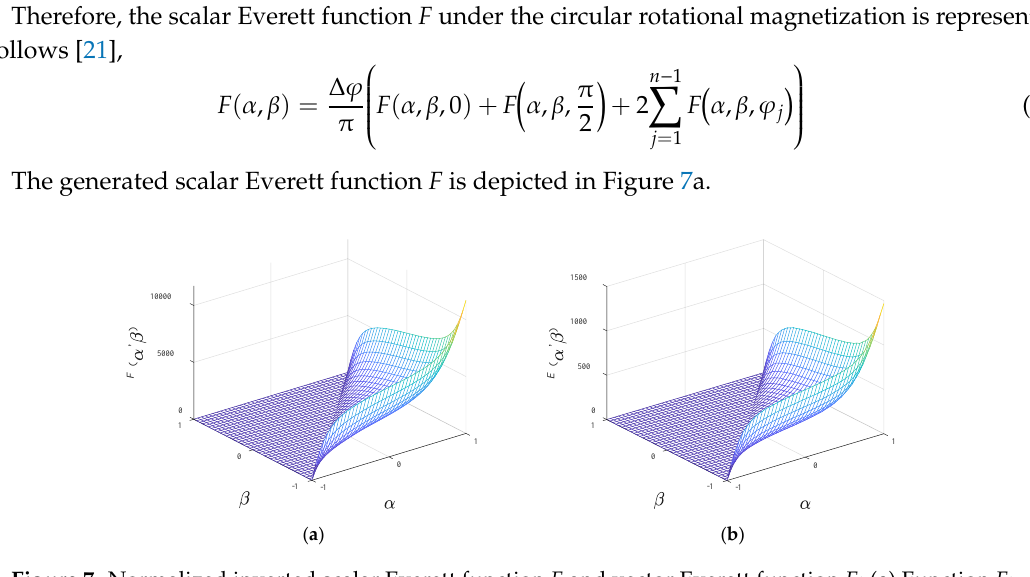
( b ) Figure 6. Normalized inverted scalar Everett function constructed from FORCs: ( a ) F x ; ( b ) F y .